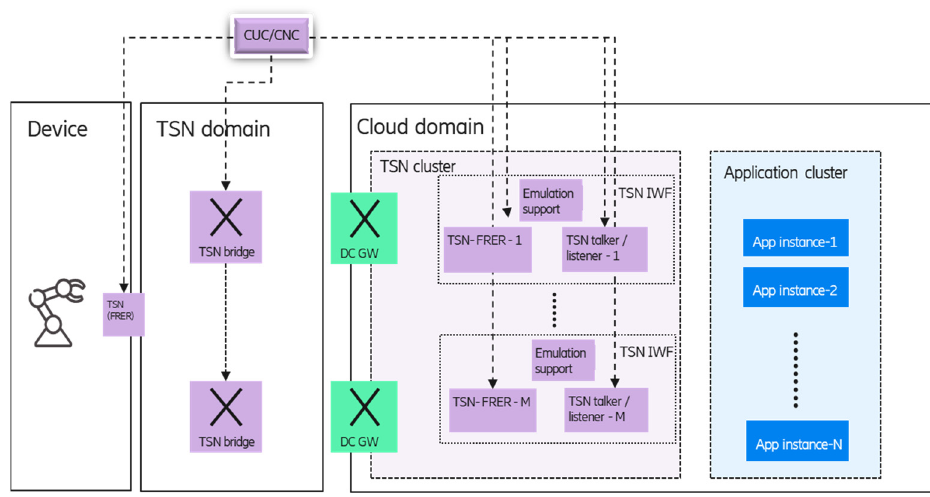
Figure 11. Architectural view of the single emulated application handling scenario.